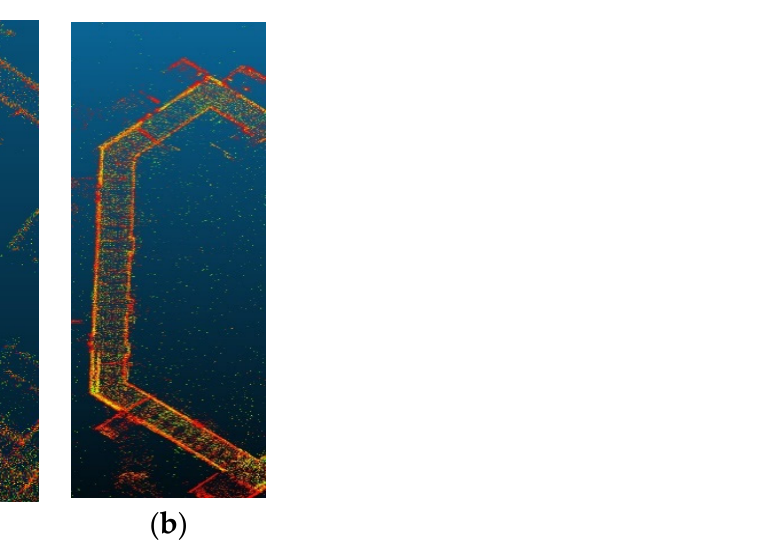
Figure 10. Comparison of LeGO-LOAM, LIO-SAM, and HSDLIO trajectories. The red line is the trajectory of HSDLIO, the blue line is the trajectory of LIO-SAM, and the black line is the trajectory of LeGO-LOAM, with the latter having drifted. To further improve the positioning accuracy of HSDLIO, the relative translational error (RTE)—the distance from the start point to the end point—is introduced. In all ex- periments, the data collection started and ended at the same point; when the positioning accuracy of the device is very high, the start and end point will coincide. The RTE, when the backpack returns to the start point, is shown in Table 1. The RTE can be computed by Equation (10):